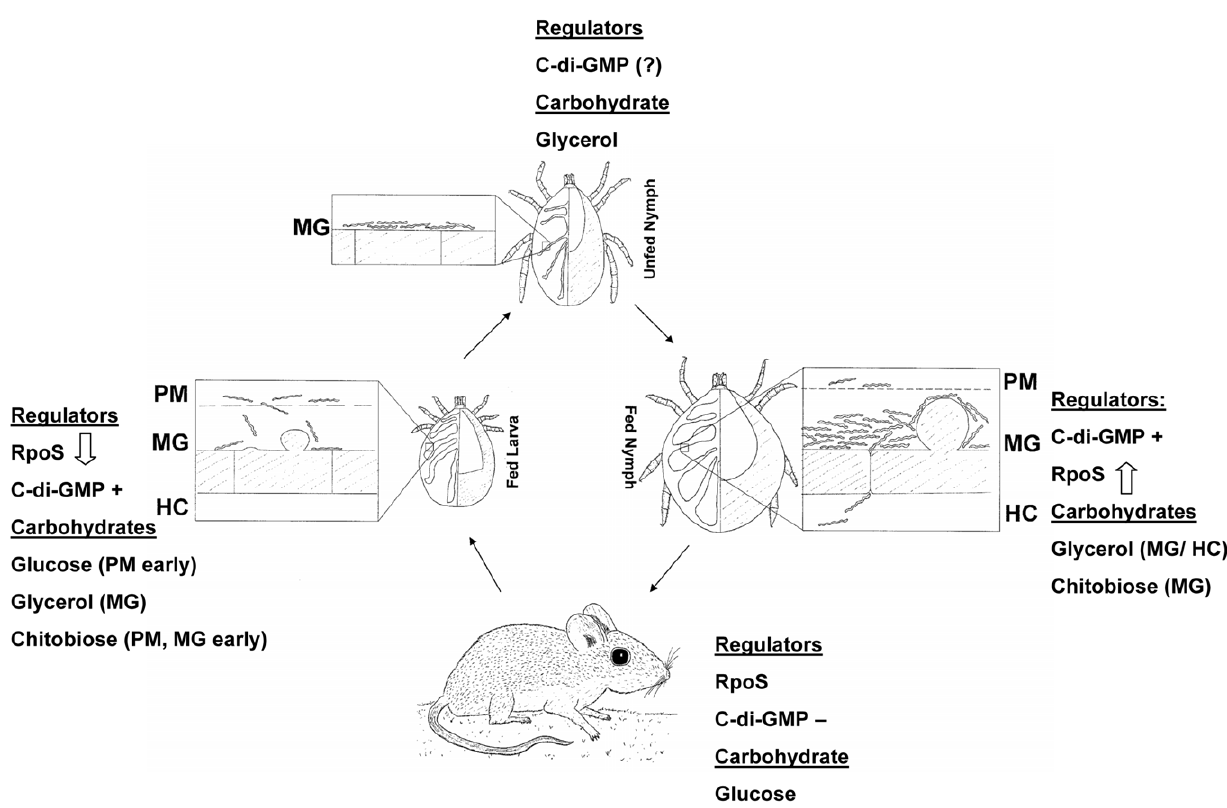
Figure 12. Carbohydrate availability and transcriptional regulators at different stages of the B.burgdorferi enzootic cycle. Up and down arrows indicate increasing or decreasing RpoS levels; c-di-GMP + and c-di-GMP 2 indicate presence or absence of c-di-GMP. PM, peritrophic matrix; MG, midgut; HC, hemocoel.